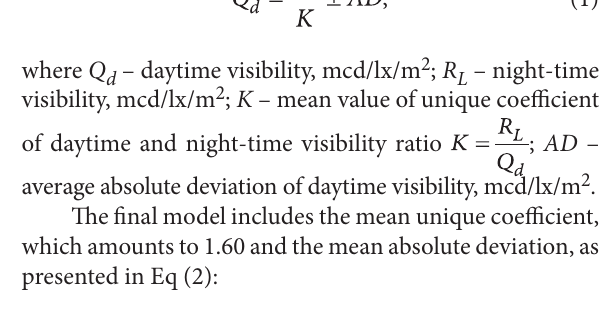
Table 6. Results of Spearman correlation between daytime and night-time visibility Visibility Daytime